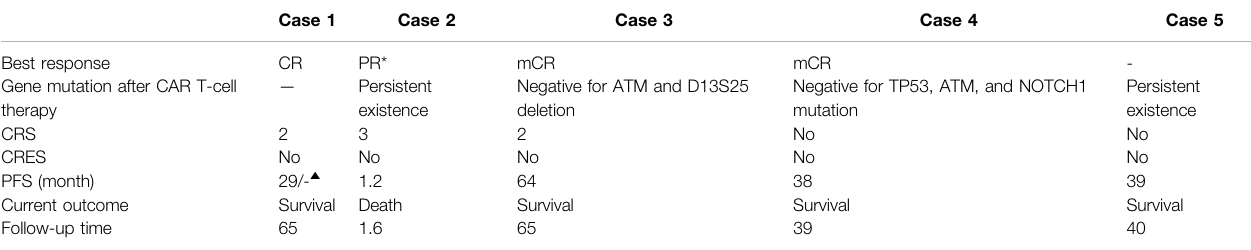
TABLE 3 | Result of CAR T patients.